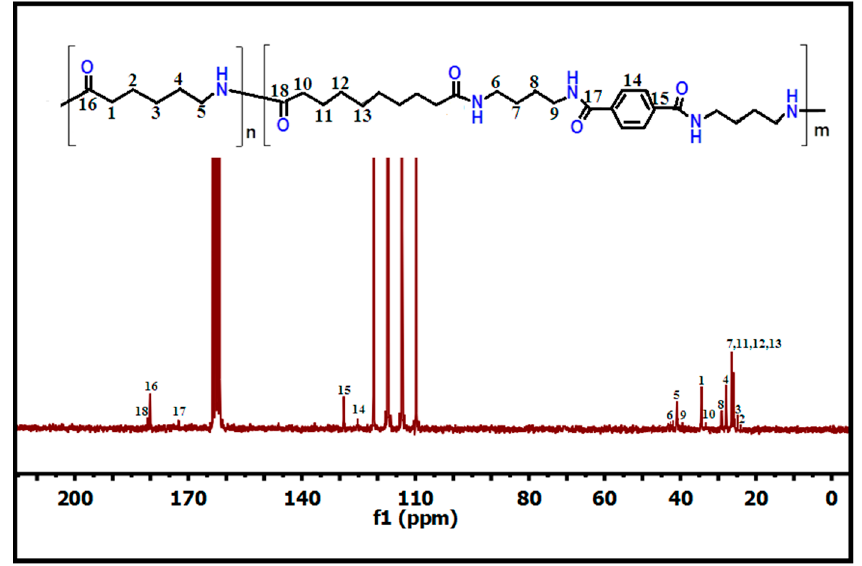
Figure 7. 13 C NMR spectrum of PA6-BABT/SA 30 copolyamide recorded in TFAA solvent. Table 1. Carbon nuclear magnetic resonance ( 13 C NMR) shift of corresponding peaks, shown in Figure 7. Carbon No. Chemical shift